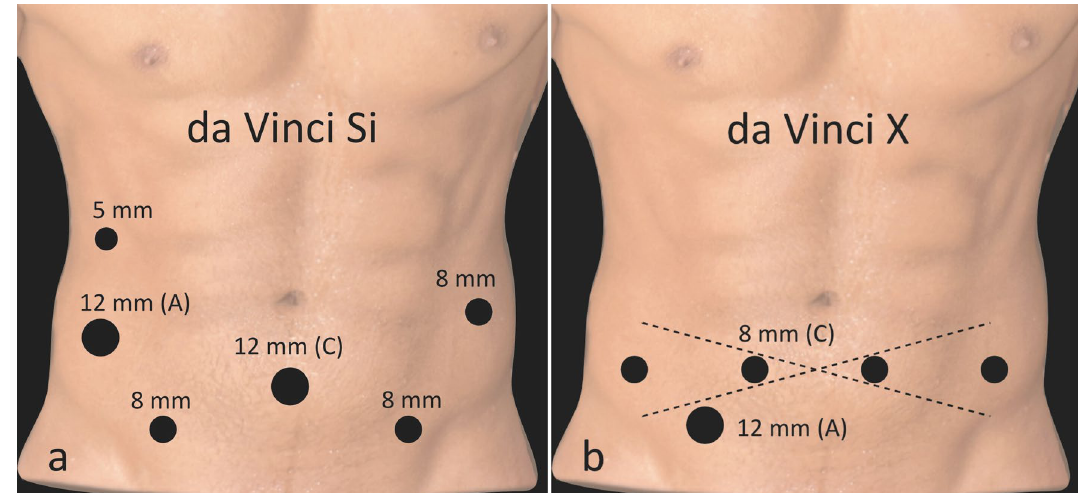
Figure 1. Port placement. ( a ) Da Vinci Si: Port placement included three 8-mm trocars—two above the anterior superior iliac spine on each side and a third one approximately 8 cm cranially on the left side underneath. The camera trocar (12 mm) was placed in the midline, 5 cm below the umbilicus, in line with the two 8-mm trocars. For the assistant physician, a 12- and 5-mm trocar was inserted on the right side below the costal arch. Port placement was the same for unilateral and/or bilateral cases. ( b ) Da Vinci X: Port placement included four 8-mm da Vinci trocars, including the 8-mm camera trocar (right lower abdomen), inserted in